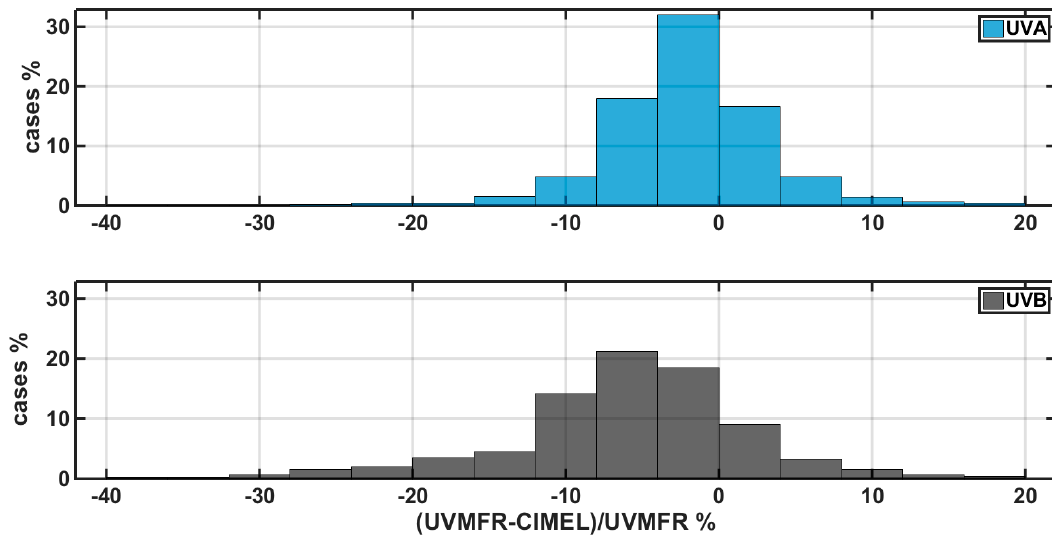
Figure 7. Relative frequency histograms of cases of UVA ( upper plot ) and UVB ( lower plot ) relative differences of GHI calculated using UVMFR and CIMEL SSA input as described in Table 1, for all available synchronous data.